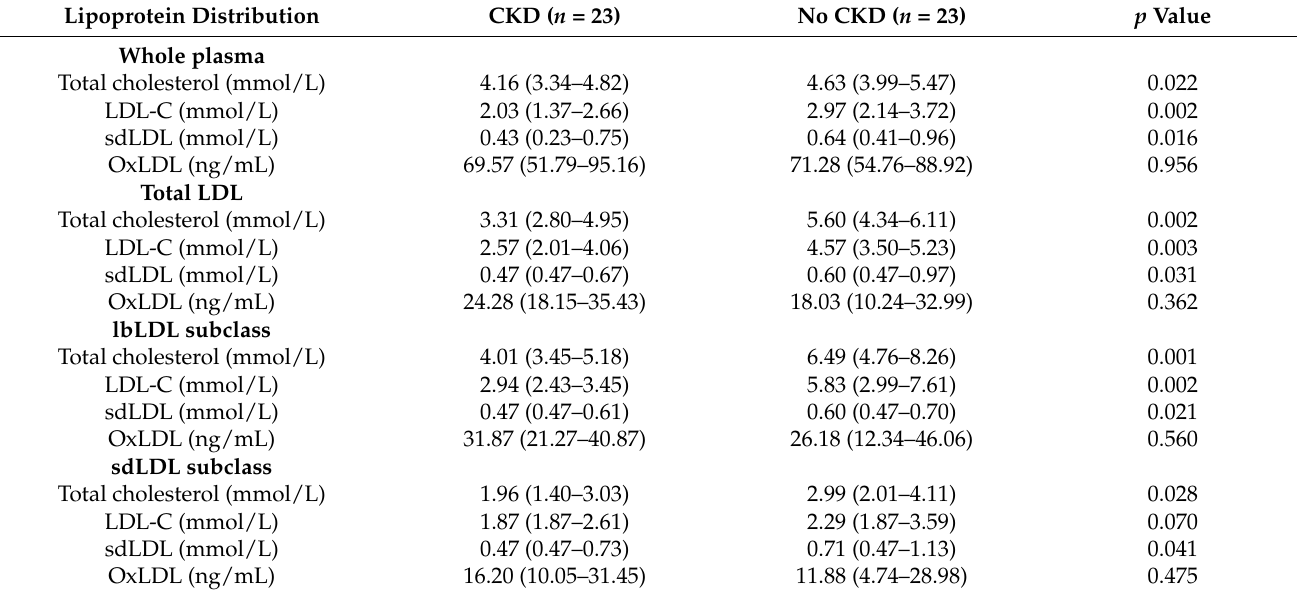
Table 6. Lipoprotein distribution of atrial fibrillation patients with and without chronic kid- ney